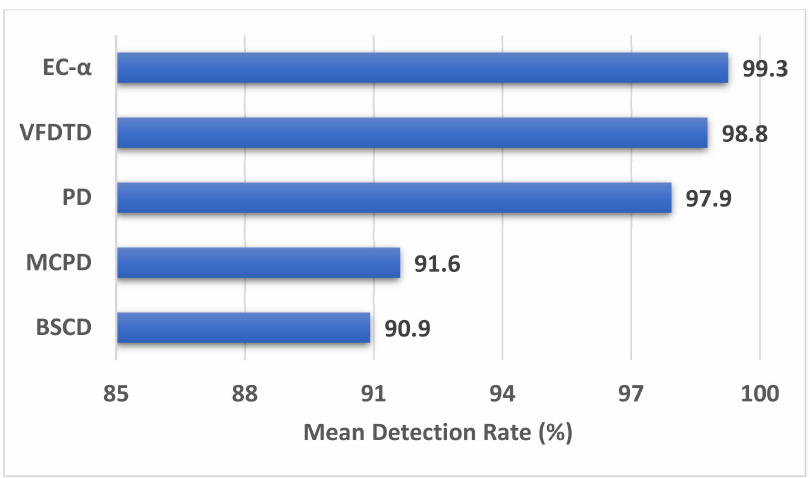
Figure 9. Overall transient starting point detection accuracy of the methods at high